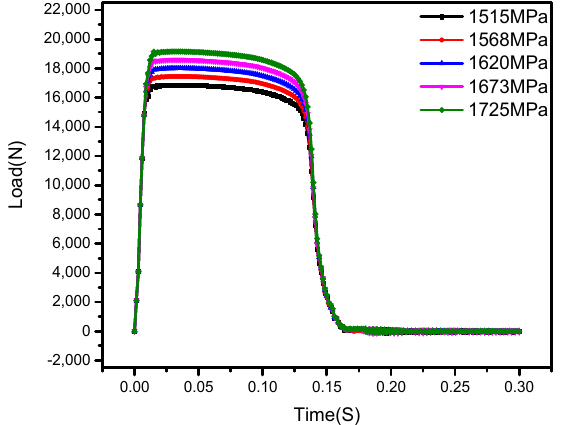
Figure 12. Tensile loads under different tensile strengths with a notch bottom diameter of 3.0 mm.